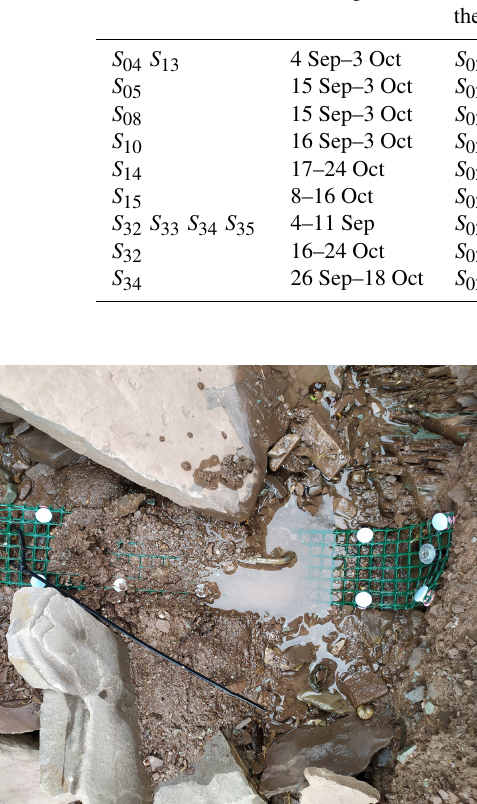
Table B2. Corrections applied to some of the HOBOs of Zone 1. Sensor corrected Missing data Sensors used for Data used η the corrections